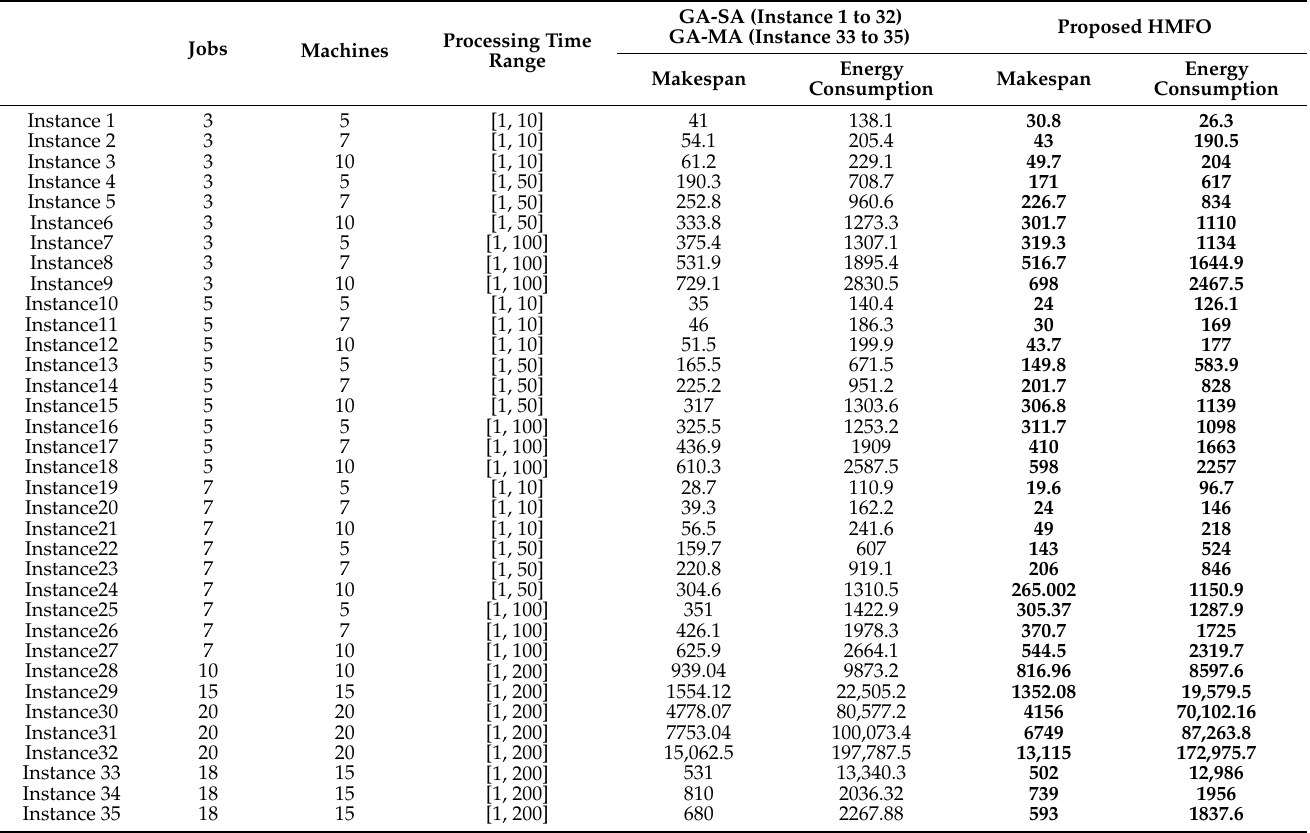
Table 7. Results of the experimental instances with makespan and energy consumption